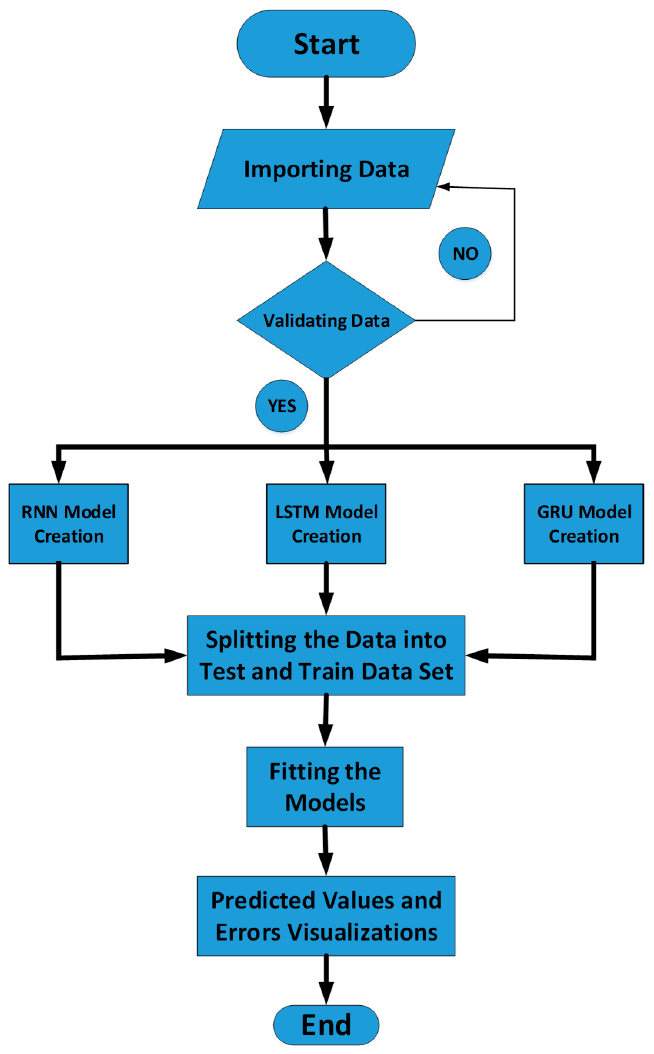
Figure 5. Procedural flow chart to find predicted values.